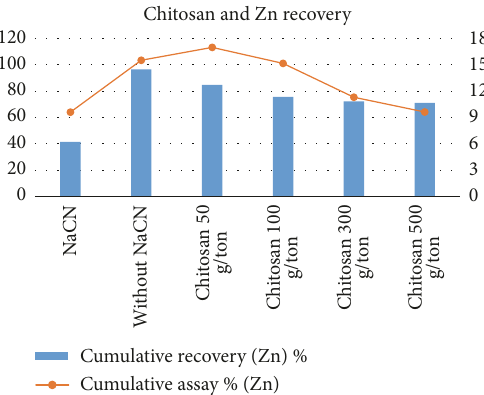
Figure 8: Copper recovery and concentrate grade as a function of chitosan dosage in comparison with NaCN depressant.